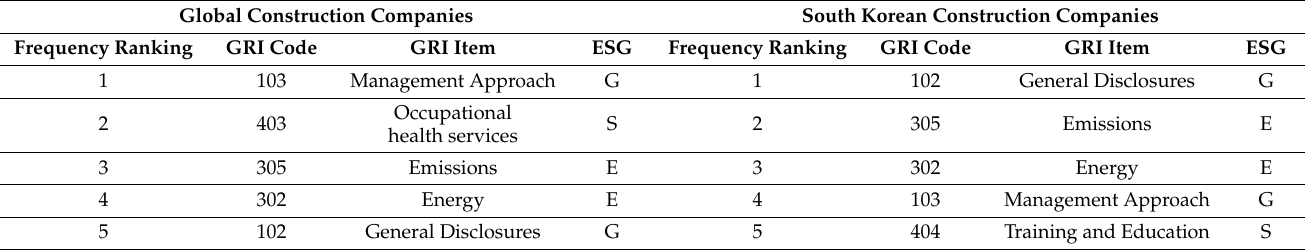
Table 12. ESG categorization of core issues among global and Korean construction